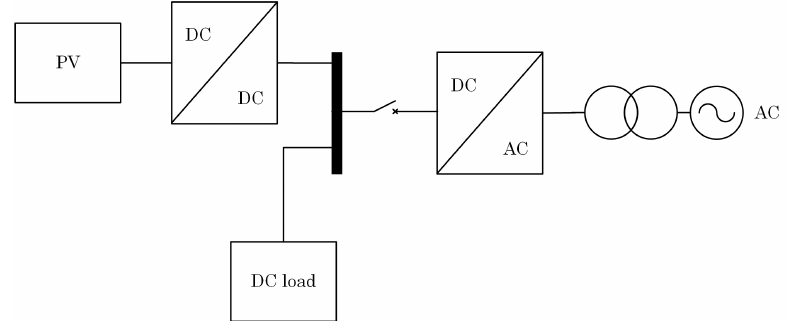
Figure 9. Single PV